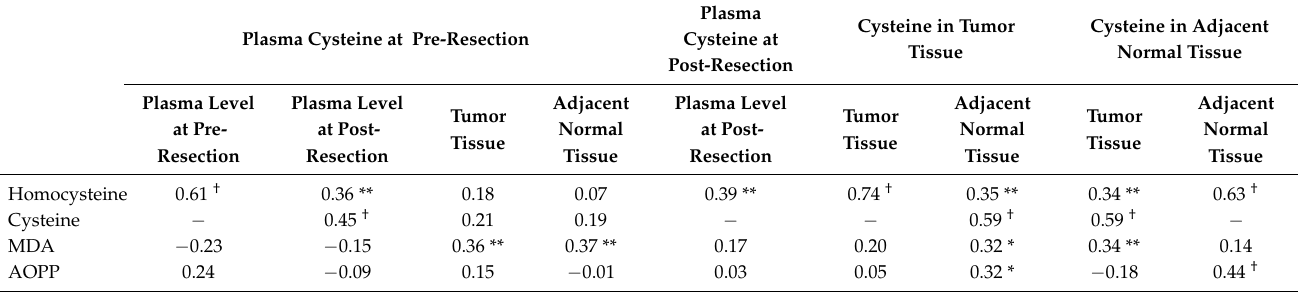
Table 4. Partial Spearman’s correlations ( r s ) of cysteine level with indicators of oxidative stress and antioxidant capacities in patients with colorectal cancer at pre-resection, tumor tissues, and adjacent normal tissues after adjusting for potential